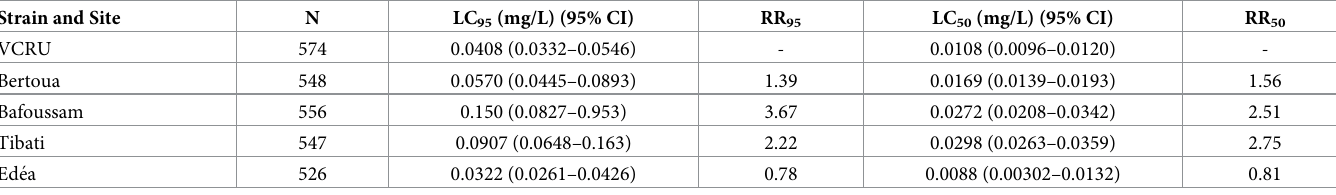
Table 2. Larval bioassays with Bti against Aedes albopictus larvae. Strain and Site N